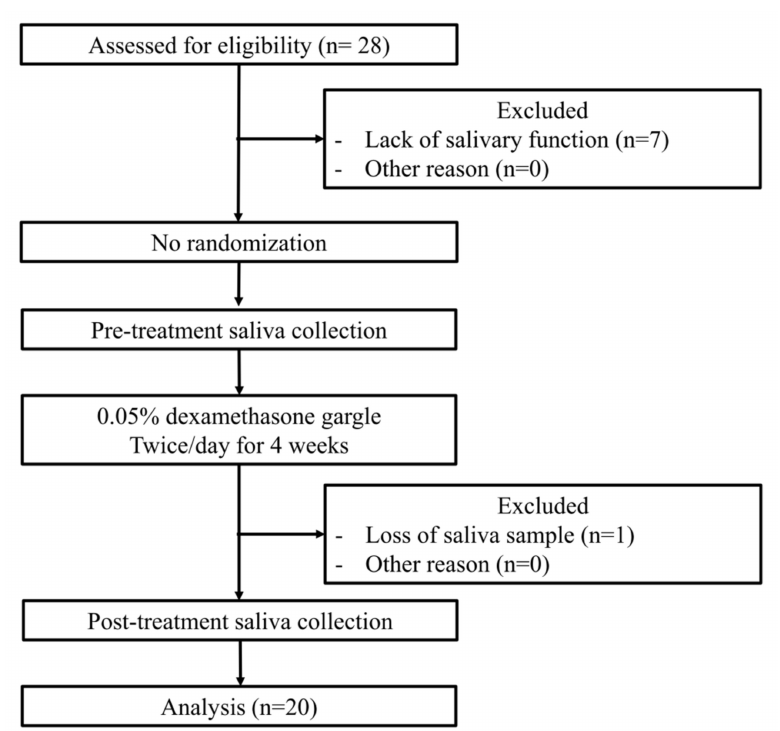
Figure 1. Flow diagram of the exclusion and research